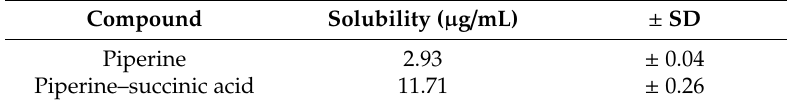
Table 2. Solubility data for piperine and piperine–succinic acid in distilled water.